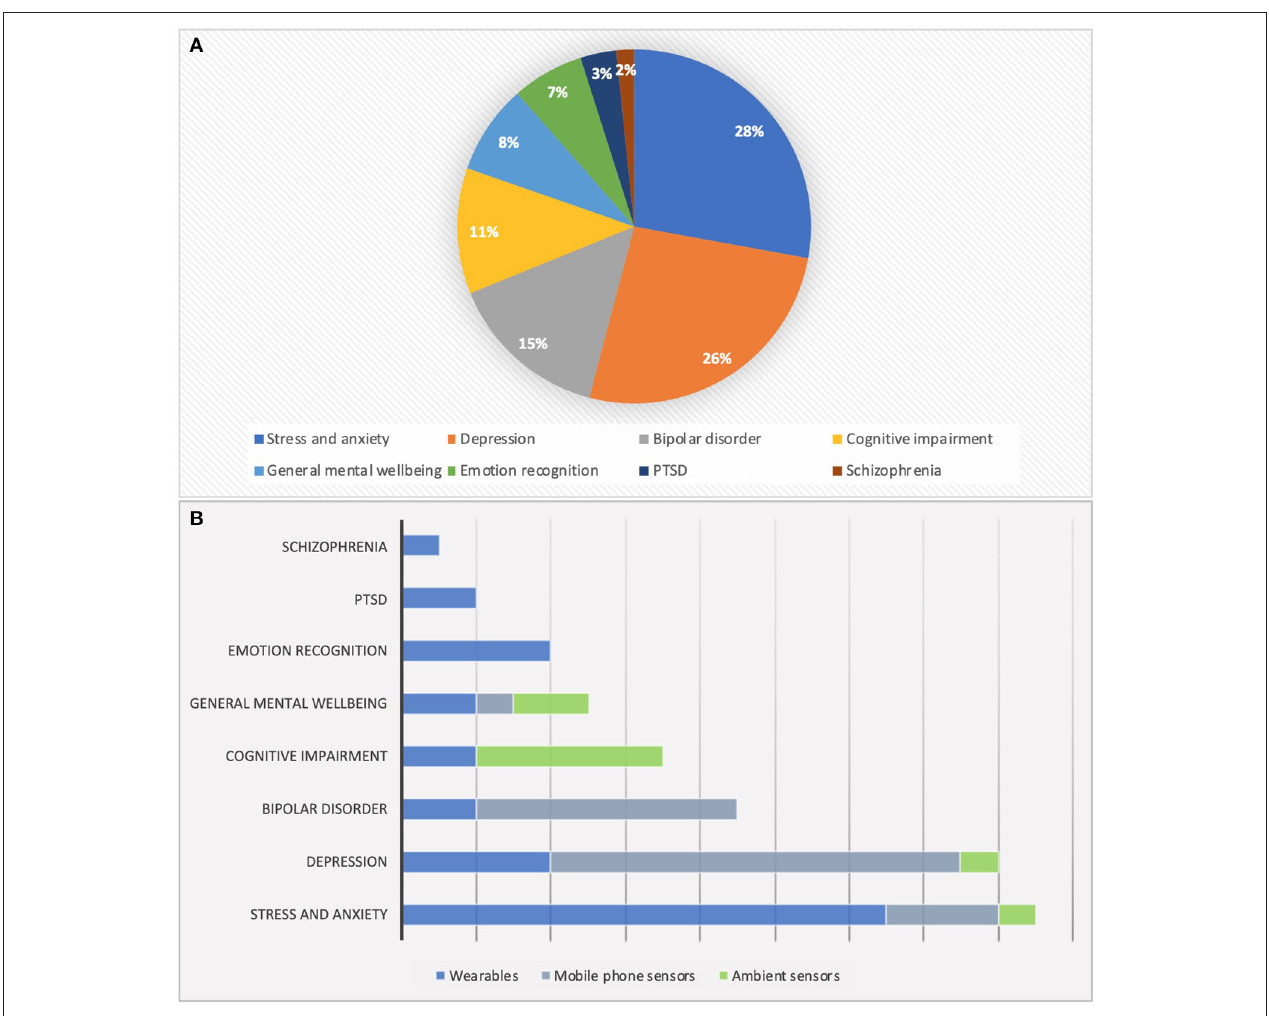
FIGURE 3 | (A) Domain of the reviewed papers. (B) Investigated sensing devices for different mental